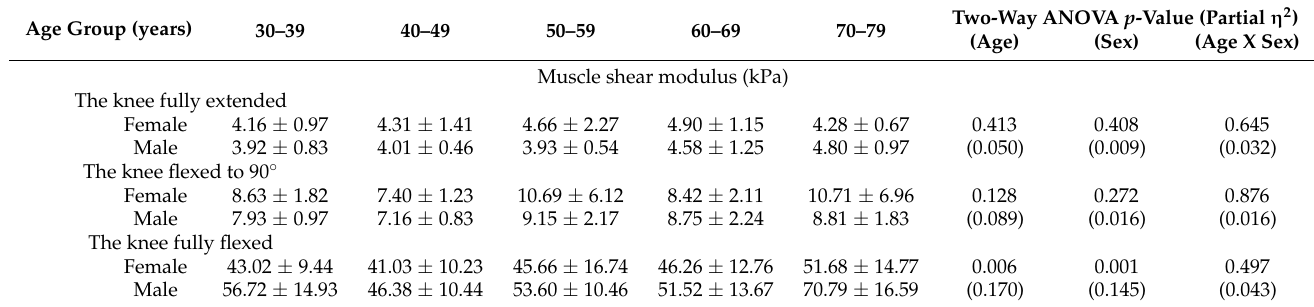
Table 2. Muscle shear modulus of the vastus lateralis (VL) of the females and males in each age group. Age Group